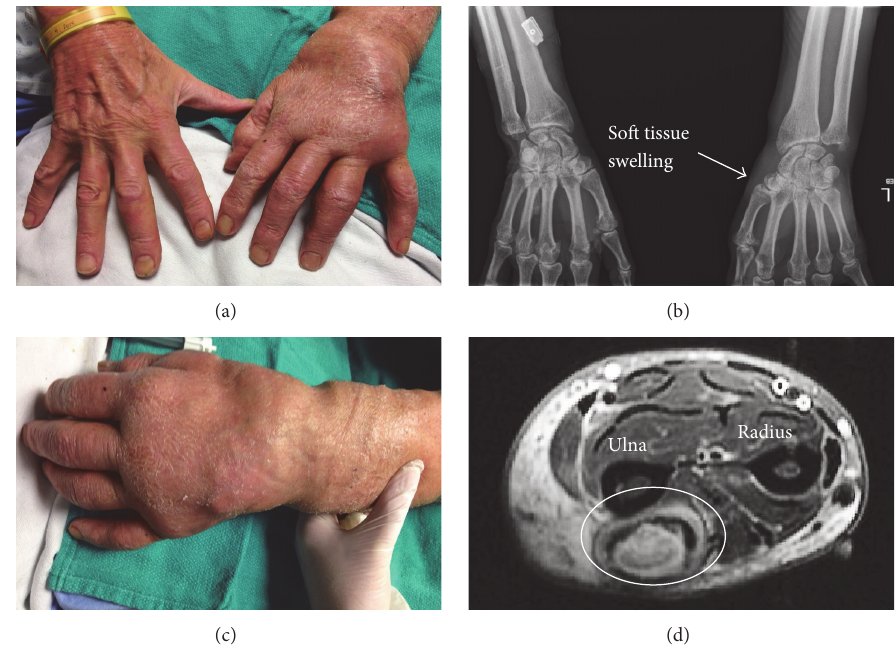
Figure 2: Sporotrichoid spreading of M. marinum via lymphatic and myotendinous spreading in disseminated disease. (a) Unilateral granulomatous disease with soft tissue swelling due to lymphatic obstruction, (b) radiograph demonstrating unilateral left soft tissue swelling in absence of erosive disease, (c) dorsal aspect of distal left forearm with visible nodules, and (d) MRI demonstrating myotendinous necrotic granuloma (white circle) in distal aspect of extensor carpi